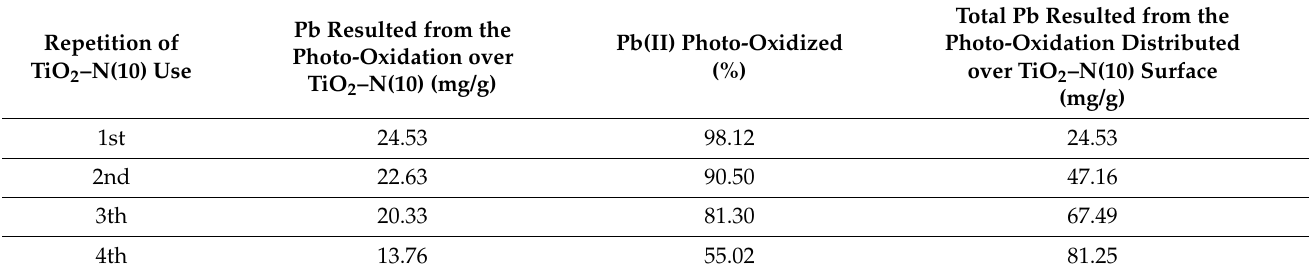
Figure 11. The activity of TiO 2 –N (10) on the Pb(II) photo-oxidation with several repetitions. Table 3. The activity of repeatedly used TiO 2 –N (10) photocatalyst.